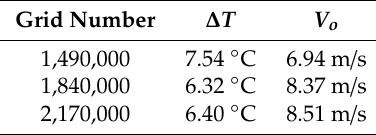
Table 1. Grid-independence validation at the ventilation condition of 20 ◦ C and 600 m 3 / h.